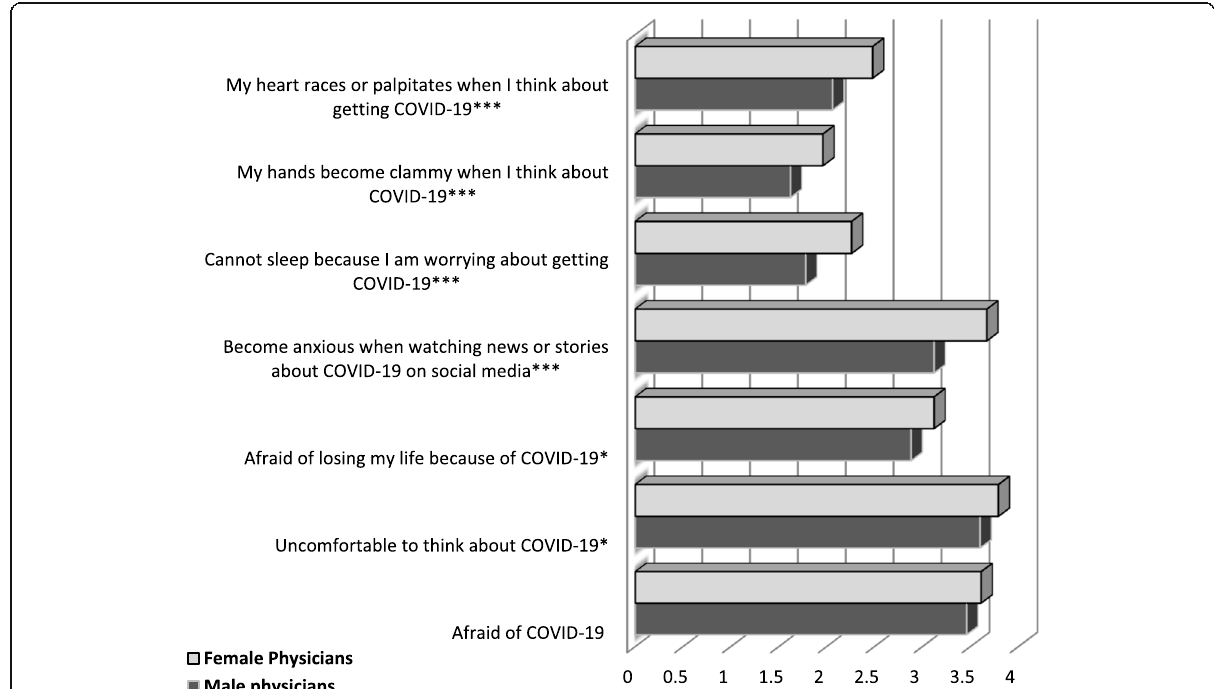
Fig. 1 Distribution of items of FCV-19S by physician's gender. * P < 0.05, ** P < 0.01, *** P < 0.001. COVID-19 coronavirus disease 2019, FCV- 19S Fear of COVID-19 Scale